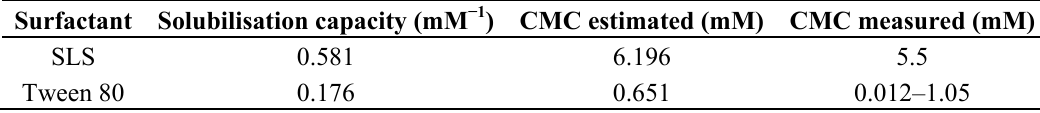
Table 1. Estimated molar solubilisation capacity and